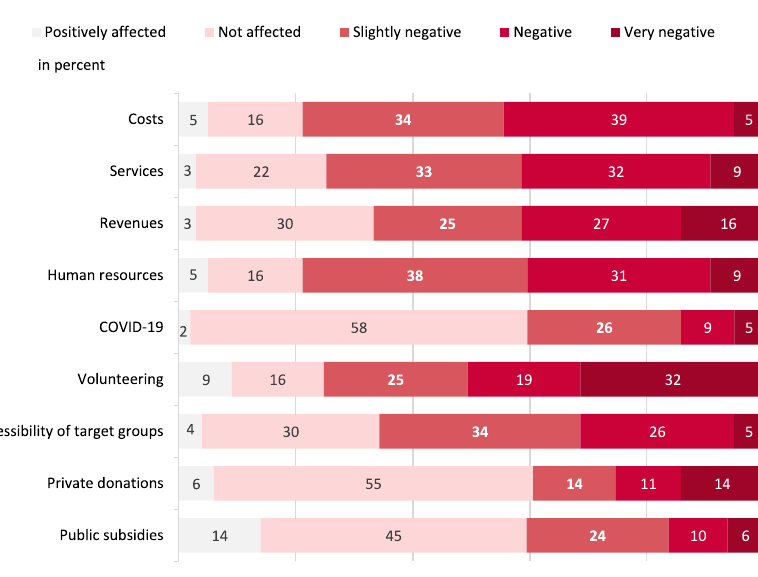
Figure 2: Areas of affectedness of social service CSOs in all fields (n = 99). (Source: Millner et al. 2020,